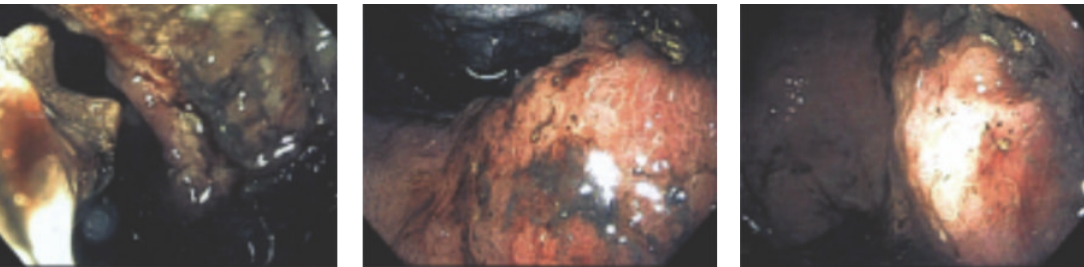
Figure 3: Esophagogastroduodenoscopy showing lesions in the antrum, body of the stomach, fundus, cardia, and the lesser curvature of the stomach body consistent with